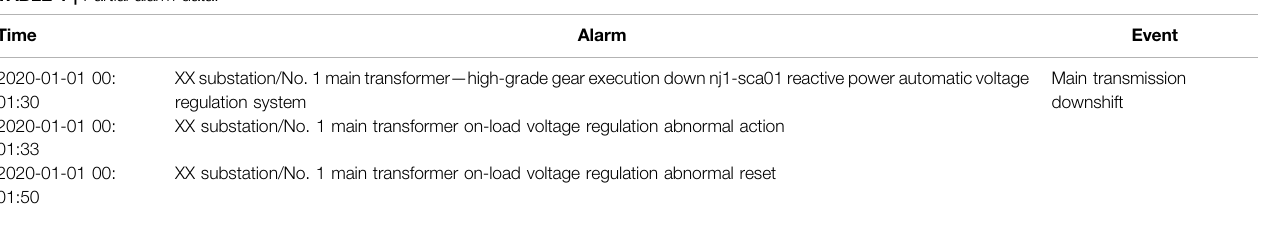
TABLE 1 | Partial alarm data.